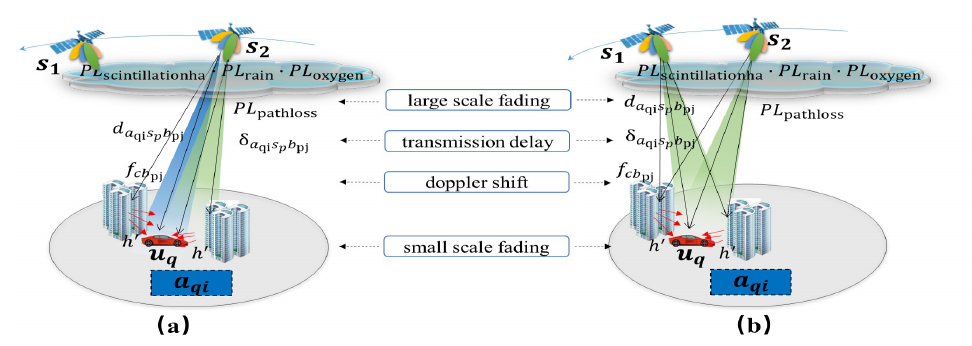
Figure 3. Propagation model. ( a ) Single-satellite multi-beam. ( b ) Multi-satellite